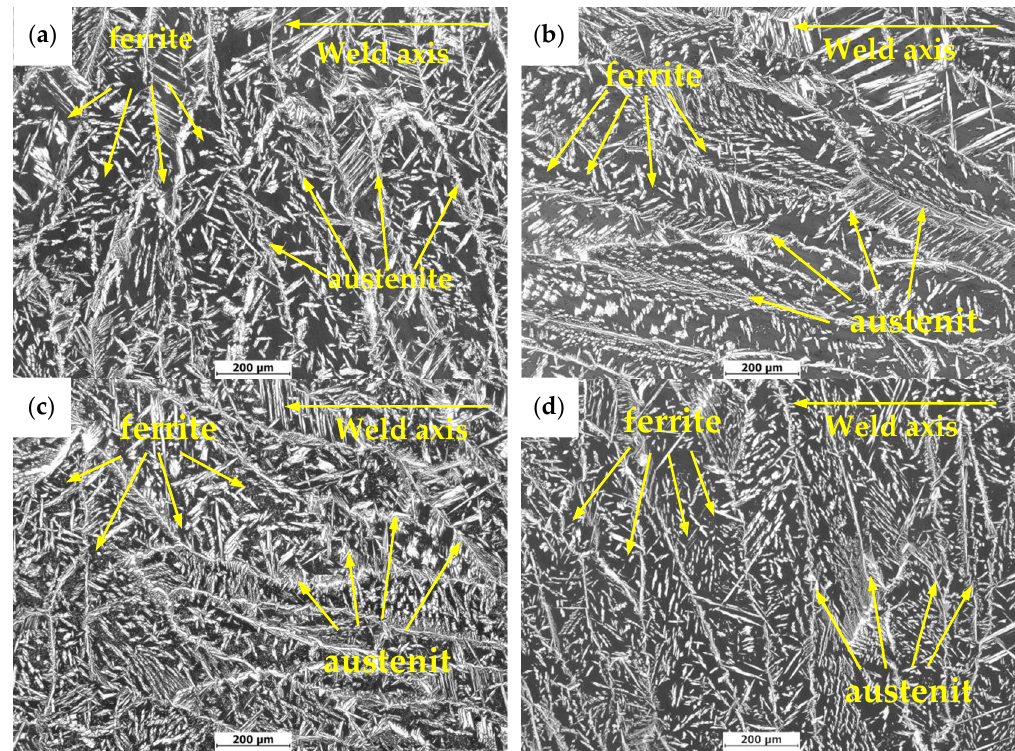
Figure 4. Microstructure of DSS 2205 weld seam area with different treatment methods: ( a ) untreated; ( b ) pneumatic chipping hammer; ( c ) ultrasonic peening treatment; ( d ) heat treatment.